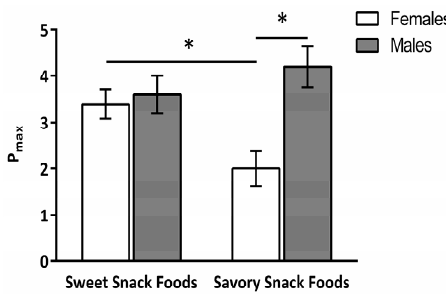
Figure 2. Interaction between gender and snack food type for Pmax (number of schedules completed to earn a snack food reinforcer). * indicates a significant ( p < 0.05) difference between means. Data are expressed as mean ± standard error (SE). P max for sweet snack foods was greater than for the savory snack foods for the women only. P max for the savory snack foods was greater in men than women but, there was no gender difference in the P max of the sweet snack foods.